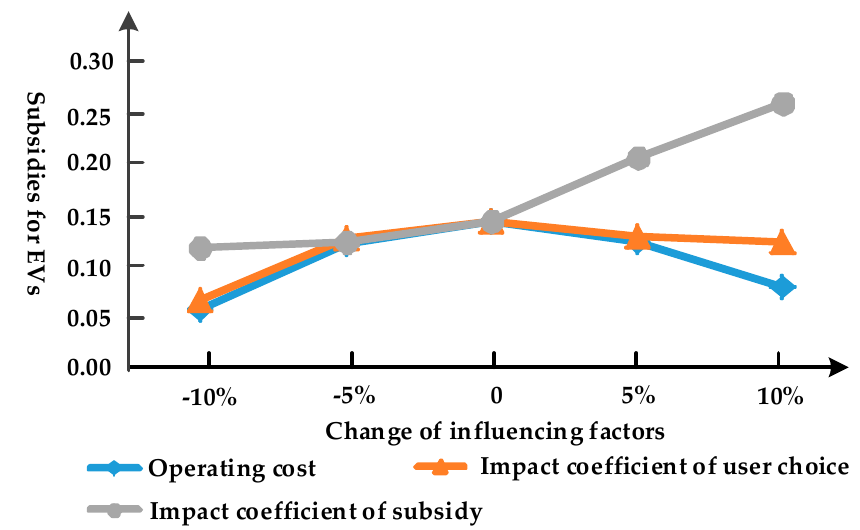
Figure 6. Curve of prices per minute.